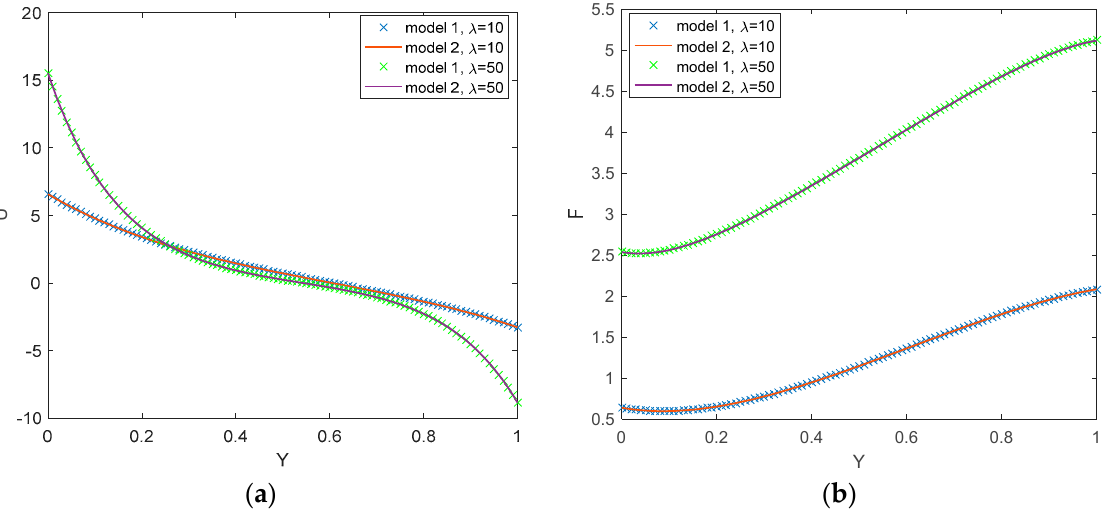
Figure 3. Comparison of velocity and temperature profiles for Pe = 1 ( a , b ) for two hybrid nanofluid models: first, see [53,54] (plotted by x) and second [45,55] (straight line).